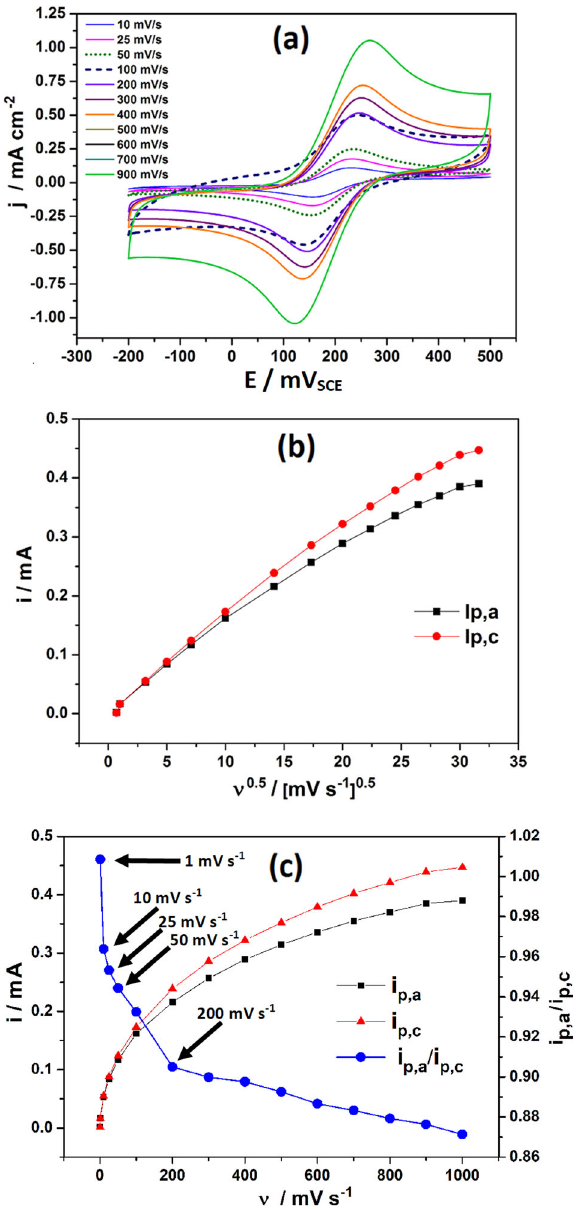
Fig. 4 Cyclic voltammetry data of CFRP. Cyclic voltammetry data of CFRP in 0.1 M KCl + 1 mM Fe[(CN) 6 ] 3 + + 1 mM Fe[(CN) 6 ] 4 + at different scan rates, a cyclic voltammogram of CFRP from 10 to 900 mV s − 1 , b plot of modulus of peak currents vs. v 1/2 ( √ of scan rate) for CFRP in 0.1 M KCl + 1 mM Fe[(CN) 6 ] 3 + + 1 mM Fe[(CN) 6 ] 4 + , c plot of modulus of peak currents and ratio of anodic to cathodic currents (i p,a /i p,c ) vs. v (scan rate) for CFRP in 0.1 M KCl + 1 mM Fe[(CN) 6 ] 3 + + 1 mM Fe [(CN) 6 ] 4 + Using the Randles-Sevcik equation (Eq. 2) and the well-reported diffusion coef fi cient of ferrocyanide in 0.1 M KCl (7.20 × 10 – 6 cm 2 s − 1 ), the electrochemically active surface area was calculated at different scan rates and presented in Table 1.